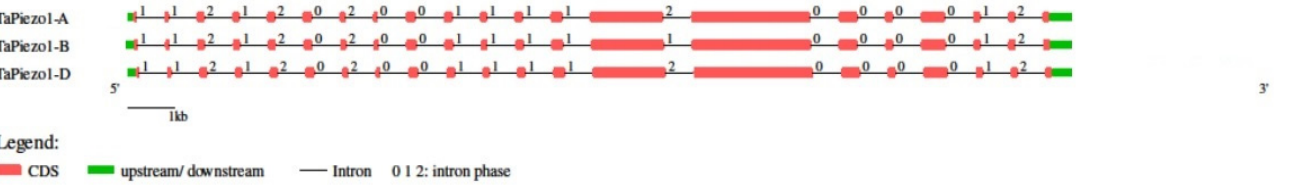
Figure 2. Phylogenetic analysis of Piezo proteins of A. thaliana (AtPiezo1), O. sativa (OsPiezo1), T. aestivum (TaPiezo1-A, TaPiezo1-B and TaPiezo1-D), B. rapa (Bra004418|Bra004418.1, Bra021452|Bra021452.1), B. distachyon (BRADI_2g13251v3|KQK04385), G. max (GLYMA_19G238300 ate (A4A49_01634|OIT06222), S. bicolor (SORBI_3003G170700|KXG32572), and Z. mays (Zm00001eb131990|Zm00001eb131990_T001). The phylogenetic tree represents the clustering of Piezo proteins into two clades, and each clade is colored differently.